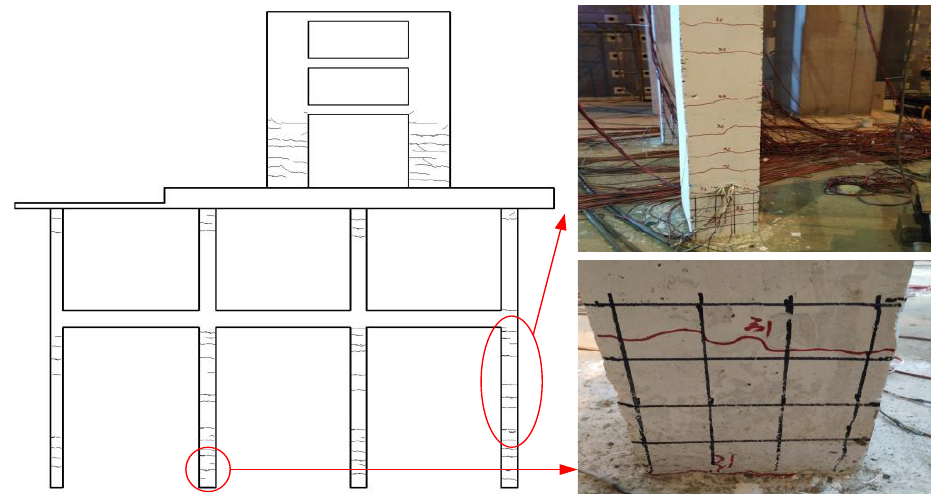
Figure 16. 8I-MCE damage condition. 9I-MCE damage condition: Under the 9I-MCE condition, the damage of the first floor was more serious, and cracks appeared at the embedded ends of each column. A horizon- tal crack with a width of 0.3 mm appeared at the junction between the top of B2 column and the slab for the first time, and a full-length crack appeared at the top and the bottom of slab on the first floor. A large number of new cracks appeared on the top of the columns on the second floor, but no cracks were found on the transfer slab, numerous inclined cracks appeared on the shear wall on the side, and the embedded end of the shear wall was seriously cracked, as shown in Figure 17b,c, which shows the detailed damage dia- gram of some nodes of the structure under the 9I-MCE condition. The failure of the beam or beam joint can consume energy during the earthquake and reduce the adverse effect of the earthquake on the column. Therefore, in the initial design, the engineers wanted to destroy the beam joints in the frame structure. However, it was found from the experiment results that although cracks were generated in the beam-column joints under the 9I-MCE condition, the damage to the beams or beam joints was not serious, which does not reach the expected design idea. The reason may be that the binding of the connecting plate on the first floor was too strong, resulting in the rotation of the floor being limited.